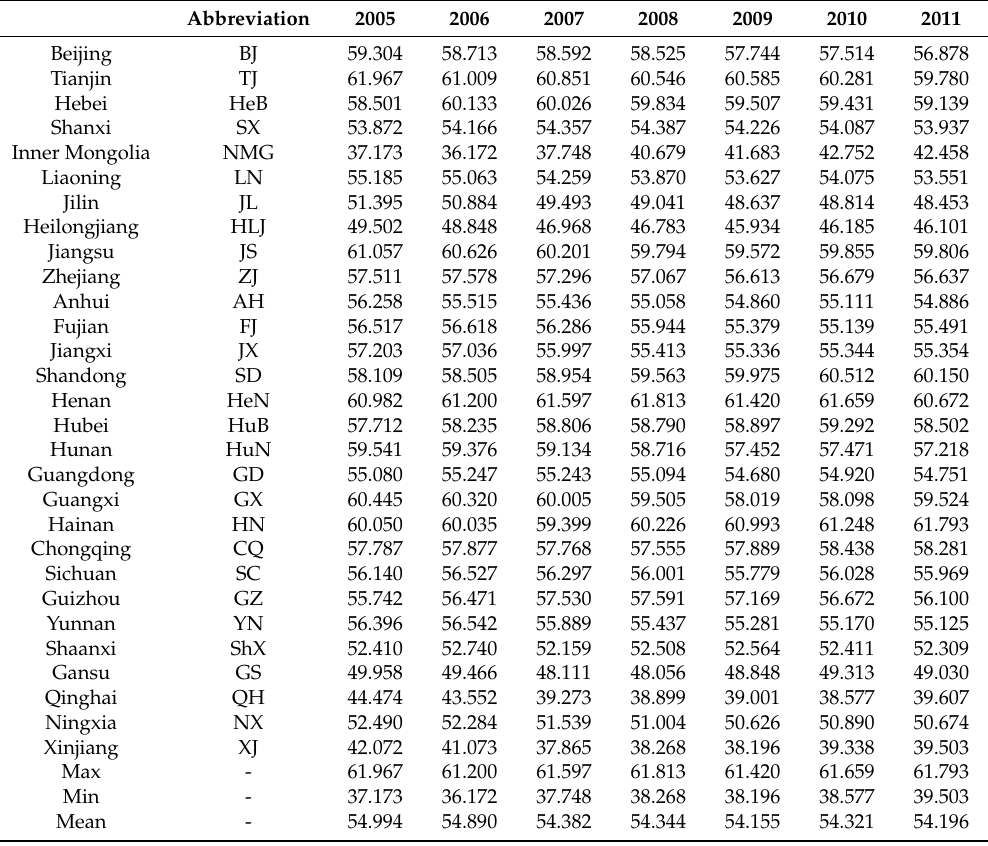
Table 2. Regional energy poverty scores from 2005 to 2011 in